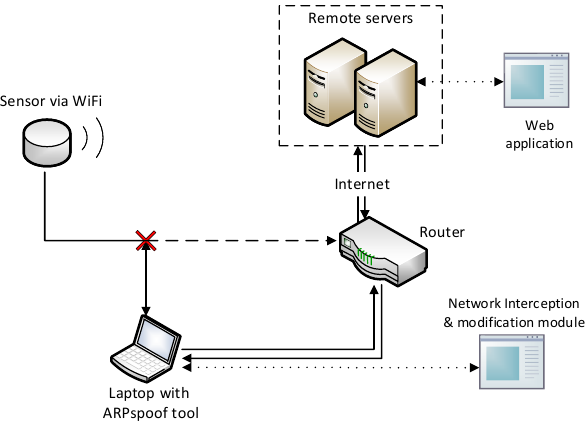
Figure 3. Experiment